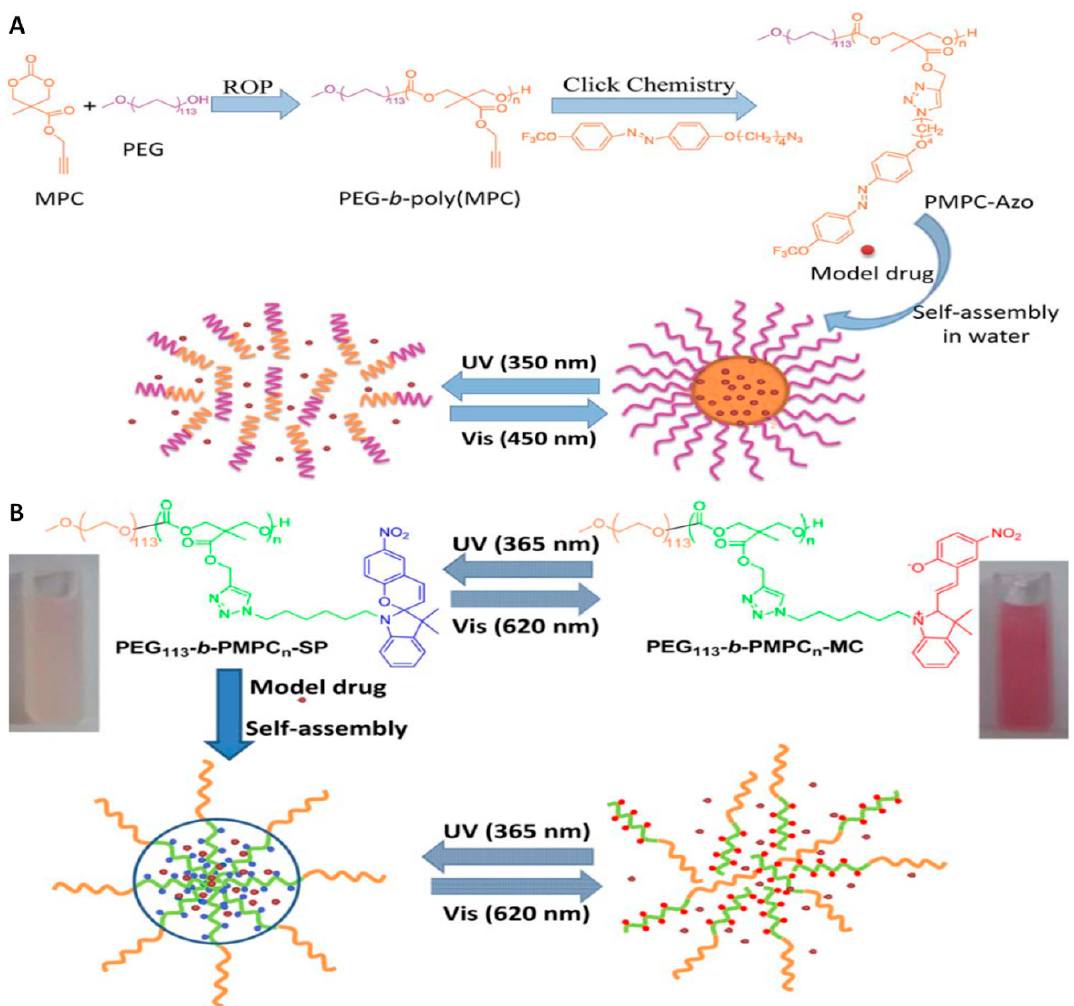
Figure 8. ( A ) Synthesis of PEGylated trifluoromethoxy-azobenzene-decorated poly(carbonate)s and schematic illustration of reversible light-responsive micelles for drug packaging and release. Reprinted with permission from ref [143]. Copyright 2014 Royal Society of Chemistry. ( B ) Schematic illustration of micelle assembly and disassembly of photo-responsive amphiphilic APC containing spiropyran group. Reprinted with permission from ref [144]. Copyright 2014 Wiley Periodicals, Inc.